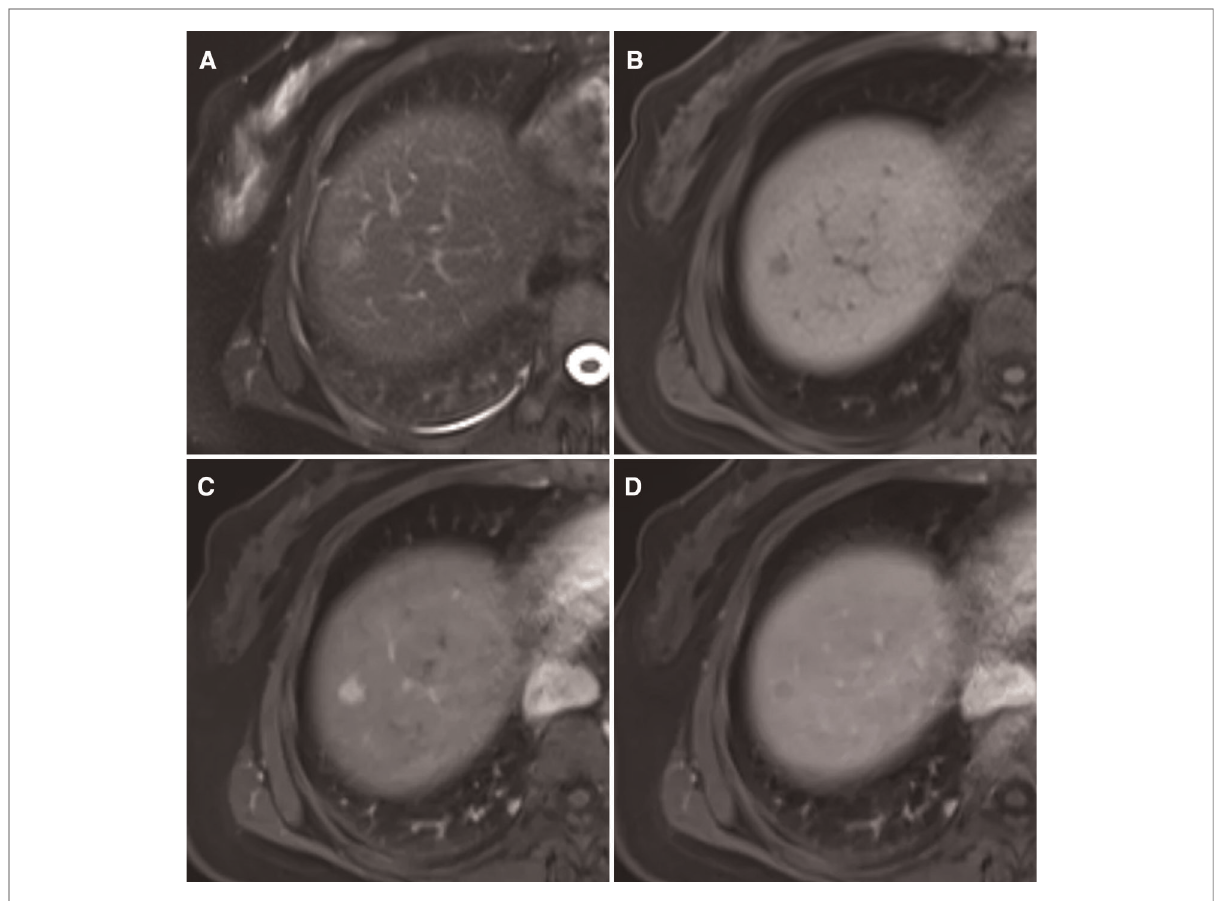
FIGURE 1 MRI fi ndings of this case ( A ) heterogeneous hyperintensity on T2 lipid-pressing sequence is shown. ( B ) Low signal on T1 lipid-pressing sequence is shown. ( C ) The arterial phase is markedly enhanced. ( D ) Hypointensities in the portal phase are